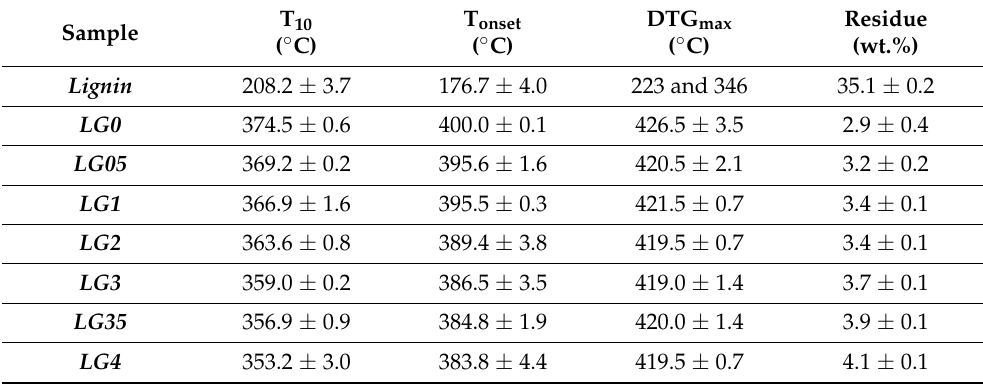
Table 2. Characteristic temperatures measured from TGA thermograms. T 10 : temperature at which 10% of the total mass is volatilized; T onset : degradation temperature; DTG max : maximum of thermal decomposition temperature; Residue: non-volatized weight fraction at 700 ◦ C.